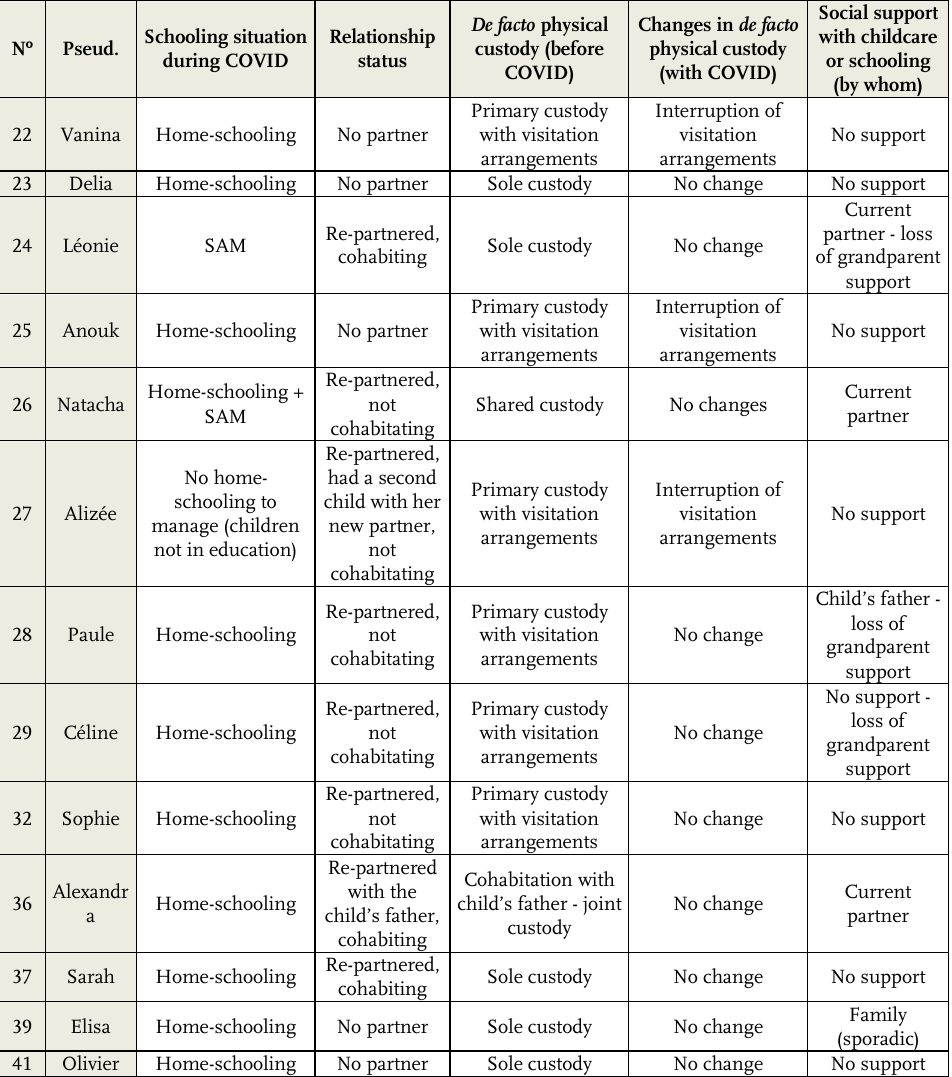
Table A.1 : Sample characteristics and changes in main life domains triggered by the pandemic